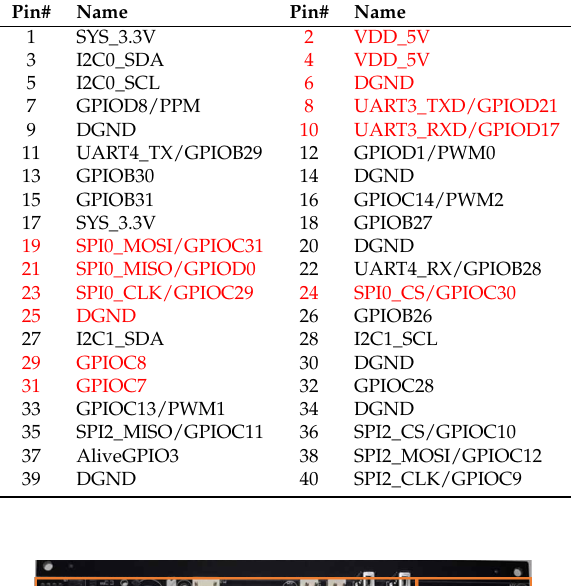
Table 2. Pin description of ARM Module.